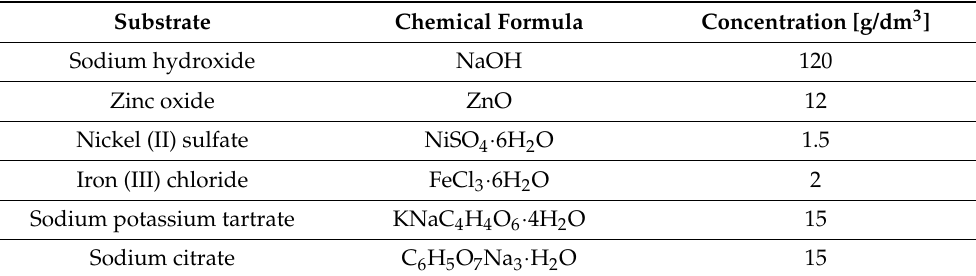
Table 2. Components concentrations of multi-constituent substance for galvanizing.